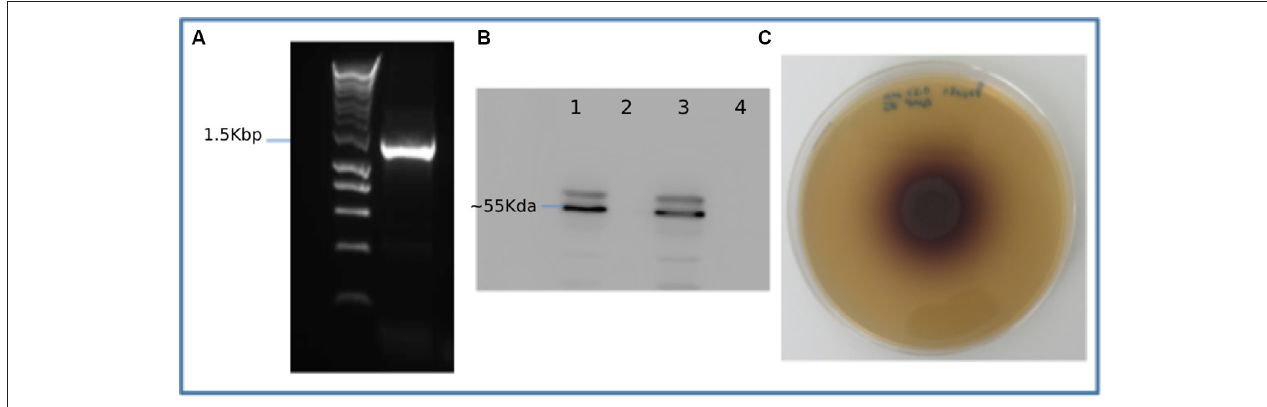
FIGURE 4 | Recombinant expression and activity testing of gene 9459: (A) Amplification of gene 9459 (B) A Western blot showing successful expression of recombinant protein lanes 1 and 3 showing duplicate induced samples and lanes 2 and 4 showing duplicate negative controls (C) An esculin hydrate- ferric ammonium citrate activity plate showing the gene 9459 clone β -glucosidase activity.